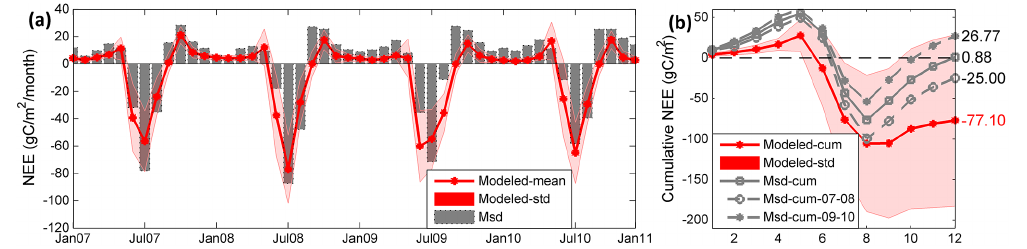
Figure 4. Monthly (a) and cumulative (b) NEE between the years 2007 and 2010 for the birch forest. Modeled NEE with spatial variability (red shadow) for each year is shown. Table 1. Tundra heath summer and whole year NEE comparisons between the modeled and published data. Tundra type